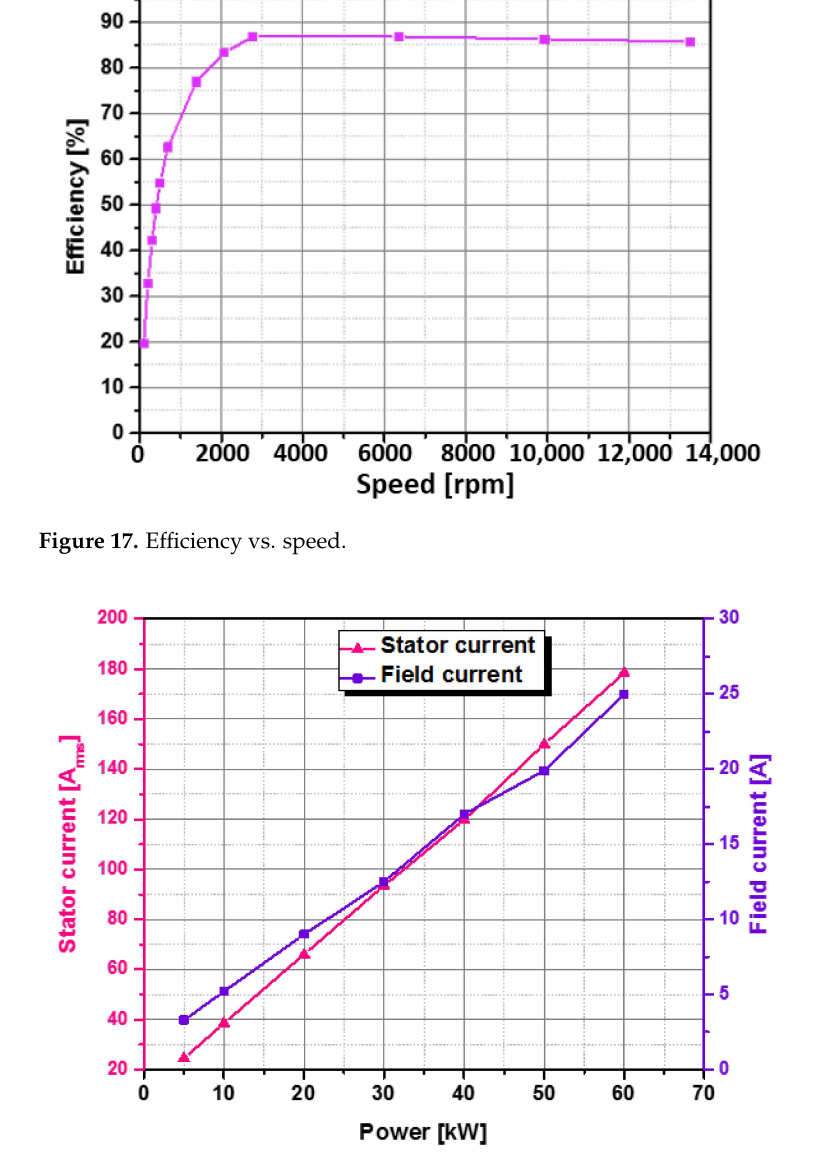
Figure 18. Stator and field current variation with the change in